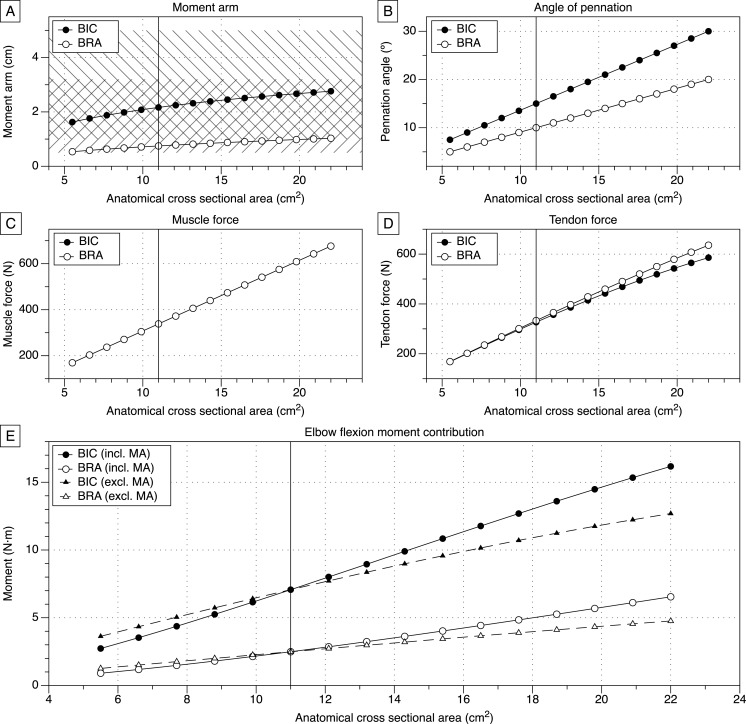
Biomechanical variables as a function of anatomical cross-sectional area.(A) Relationship between biceps brachii anatomical cross-sectional area and muscle moment arm. Negatively sloped lines are normal BIC MAs, and positively sloped lines are empirical BRA MAs (Ramsay, Hunter & Gonzalez, 2009). (B) Pennation angles of the BIC and BRA increase linearly with increases in ACSA. (C) Muscle force increases with ACSA. (BIC plots are underneath, and identical to, the BRA plots.) (D) Tendon force increases with ACSA. (E) The elbow flexion moment contributions of the BIC and BRA with changes in ACSA, both with and without the changes in MA length. Vertical lines at 11.0 cm2 indicate baseline.